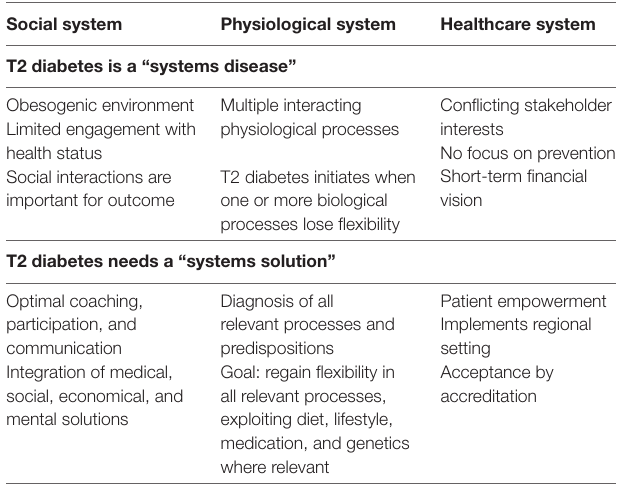
TABLe 4 | Type 2 diabetes is a systems disease where solutions need to be found in all three systems mentioned to achieve a transition from care to cure.